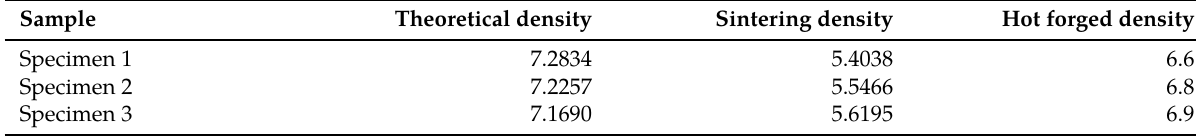
Table 2: Density attained at sintering and hot forging. Sample Theoretical